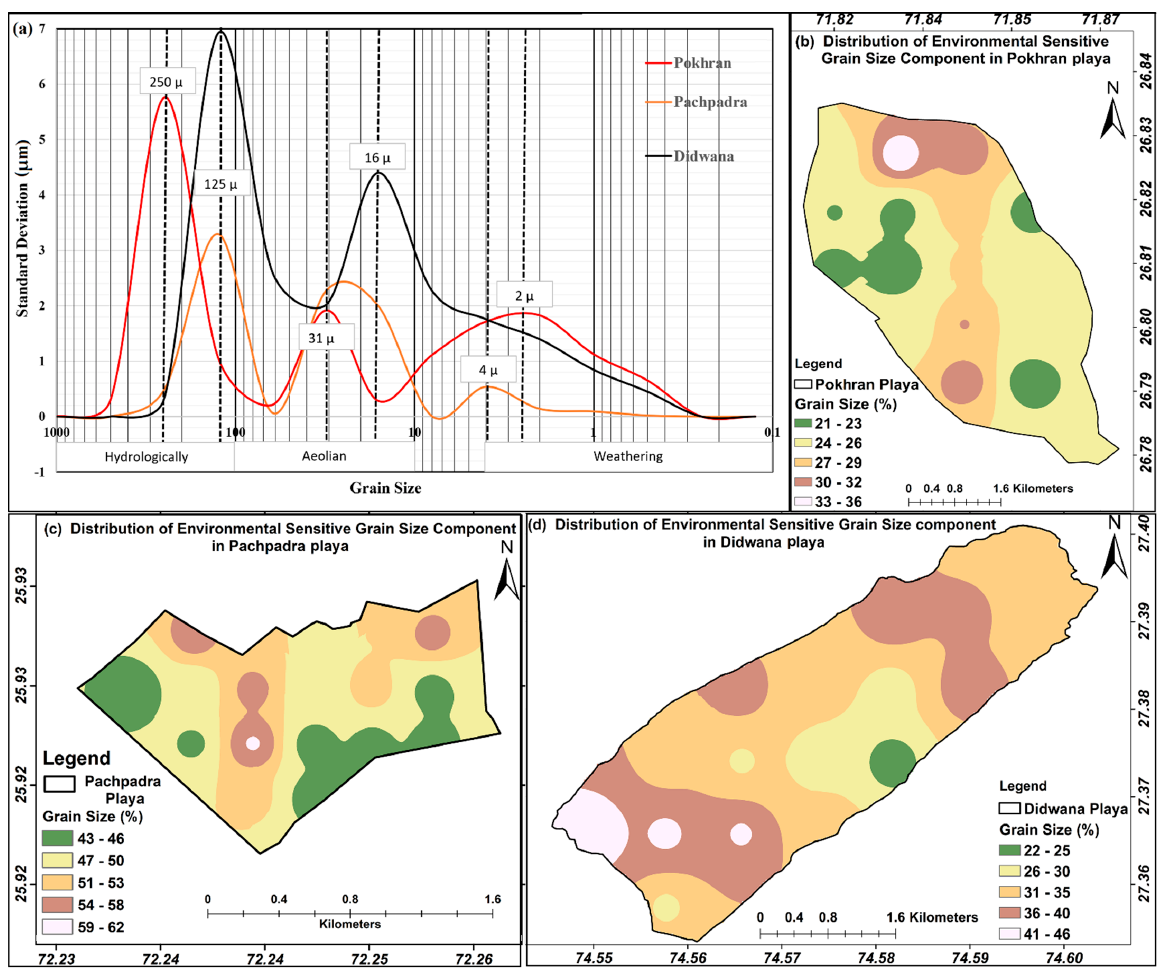
Figure 8. ( a ) Grain size vs standard deviation plot for Pachpadra, Pokhran, and Didwana playas, and distribution of environmentally sensitive grain size (ESGSC) in ( b ) Pokhran, ( c ) Pachpadra, and ( d ) Didwana playa. and distribution of environmentally sensitive grain size (ESGSC) in ( ( d ) Didwana